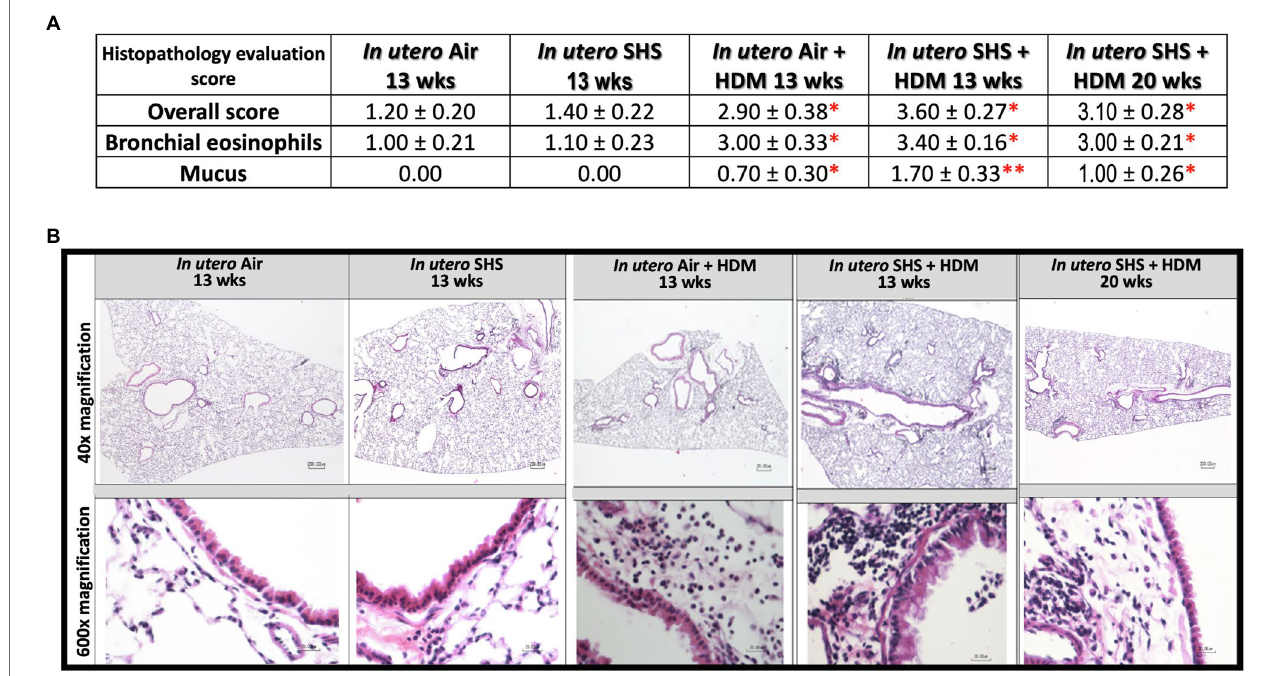
FIGURE 6 | Lung histopathology confirmed inflammation and shows mucus production following HDM treatment. (A) Histopathology evaluation score of H&E stained lung tissue of 13- and 20-week-old female mouse offspring. Overall inflammation score was 0 = normal, 1 = detectable at 100×, 2 = obvious at 20× localized, 3 = obvious at 20× widespread, 4 = complete bronchial cuffs localized, 5 = complete bronchial cuffs widespread. All other parameters: 0 = normal. 1 = minimal, 2 = mild, 3 = moderate, 4 = severe. N = 9–10 per group, data are expressed as mean ± SEM. Kruskal-Wallis test, * p < 0.05: statistically different from in utero air or